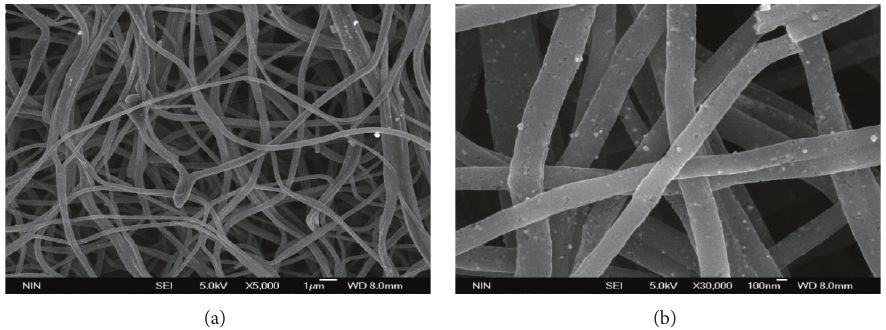
Figure 1: SEM images of as-obtained carbonized PAN fiber: (a) low magnification and (b) high magnification.